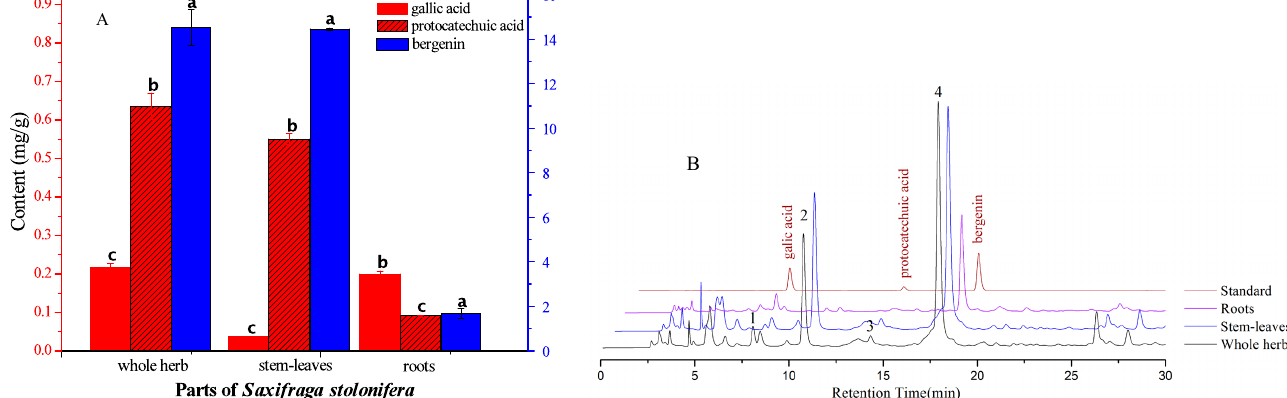
Fig. 5: (A) The distribution of gallic aicd, protocatechuic acid and bergenin in different parts of S. stolonifera (n = 8). (B) HPLC chromatogram of the standard sample, alcohol extract of the stem-leaves, roots of S. stolonifera and the whole herb . The superscript letters of the same column of data are completely different, indicating that the difference is significant (P < 0.05), and any of the same letters indicates that the difference is not significant (P < 0.05).